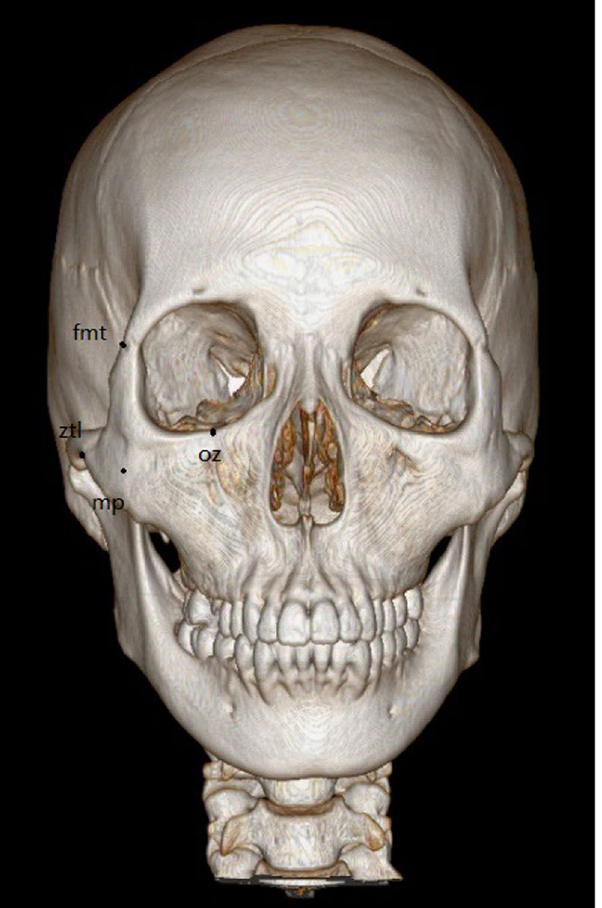
Figure 2. The locations of defined landmarks. oz (the intersection point of the zygomaticomaxillary suture and the infraorbital margin), zm (the most inferior point of the zygomatic maxillary suture), fmt (the most lateral point of the front zygomatic suture), mp (the most anterior point of the zygoma), ztl (the most inferior point of the temporozygomatic